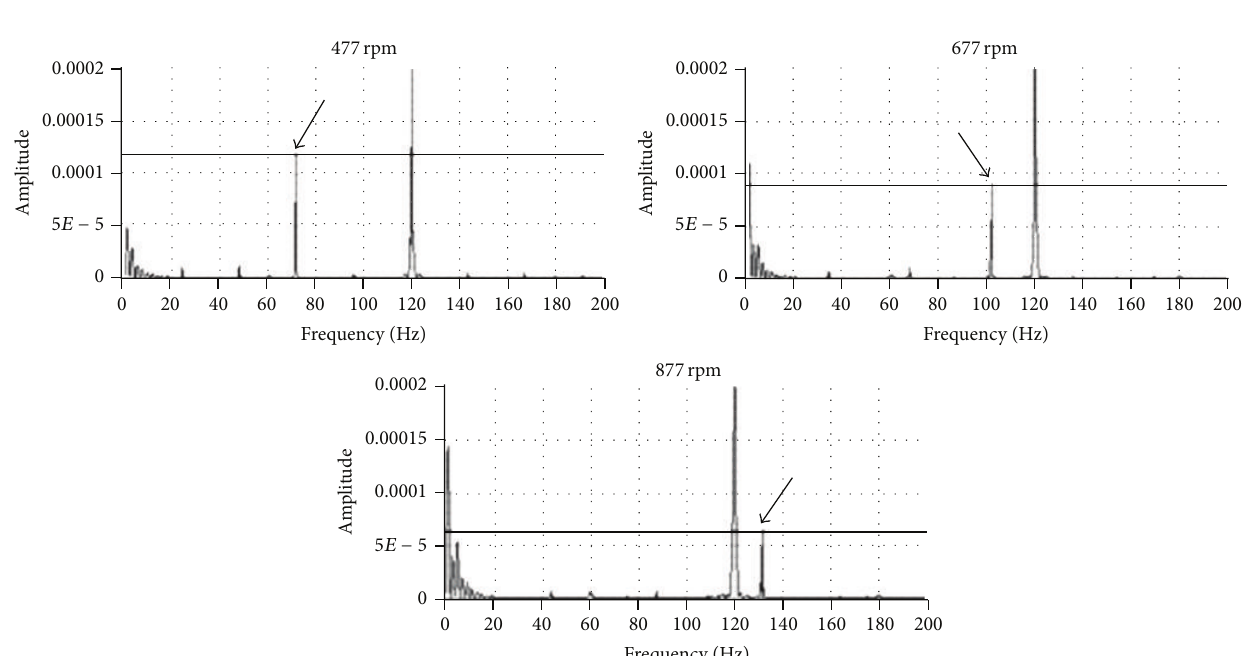
Figure 9: Defect frequency variation according to the rotating speed change of motor: the frequencies are indicated by arrows.